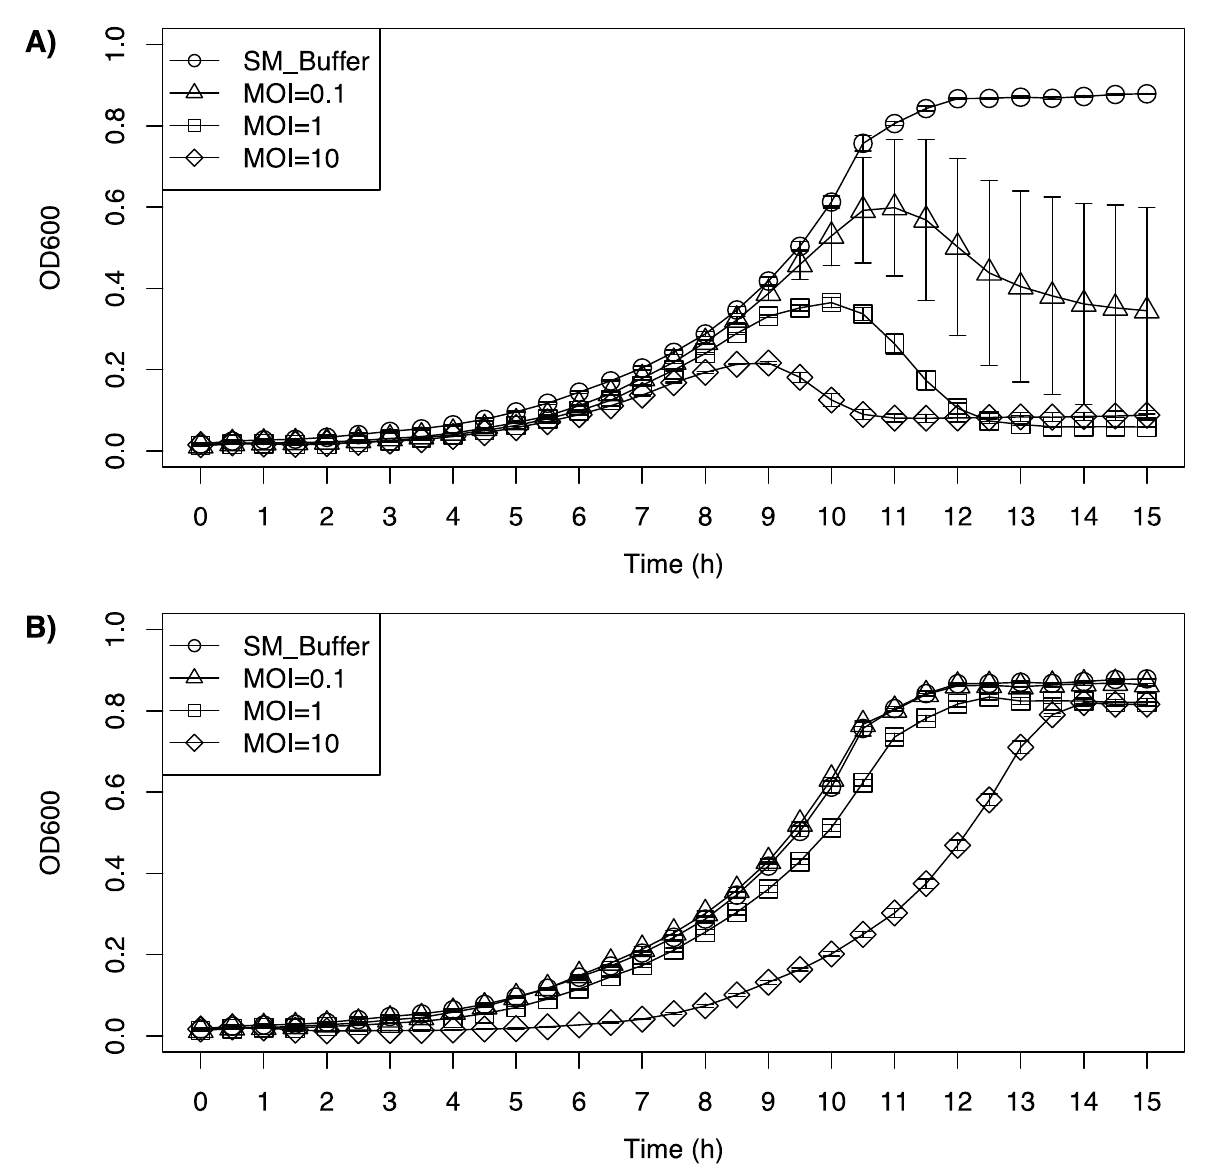
Figure 6. Inhibition growth curve of a cocktail of Listeria monocytogenes serotype 4 strains (F2365 (4b), FSL J1-208 (4a), FSL F2-695 (4a), FSL F2-501 (4b), FSL J2-071 (4c), FSL W1-110 (4b), and FSL J1-148 (4b)) treated with ( A ) LP-020 and ( B ) LP-094 at different MOIs. Unfilled circles represent SM buffer control, unfilled triangles represent samples treated at a MOI of 0.1, unfilled squares represent samples treated at a MOI of 1, and diamonds represent samples treated at a MOI of 10. Data are mean values of three biological replicates and error bars represent the standard error.